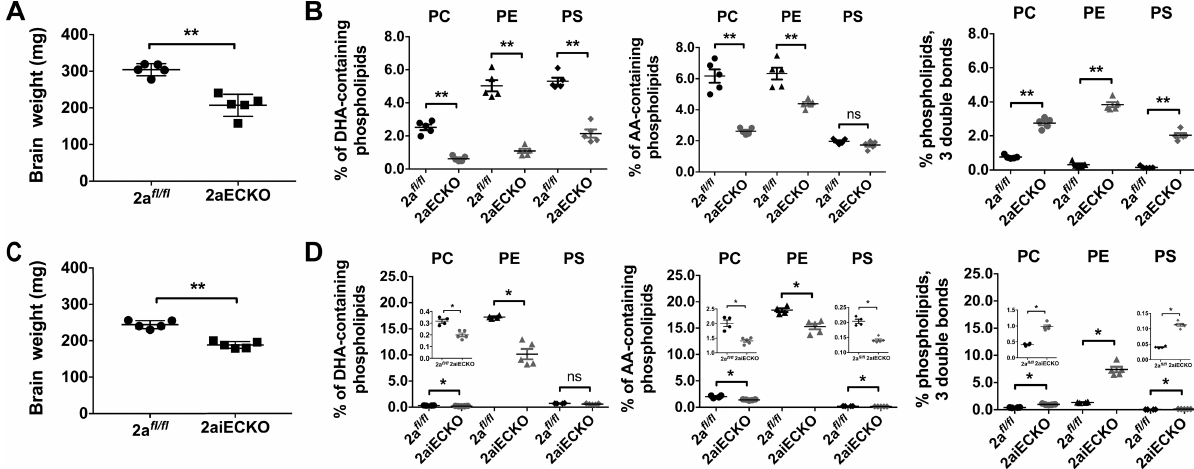
Fig 2. Mfsd2a expression at the BBB is indispensable for DHA accretion during postnatal brain growth. (A) Reduced brain weights of P8 2aECKO relative to 2a fl/fl mice. Data are represented as mean ± SE. 2a fl/fl , n = 5; 2aECKO, n = 5. (cid:3)(cid:3) p < 0.01. (B) Targeted lipidomic analysis of brains from P8 2a fl/fl and 2aECKO mice. Percentage PC, PE, and PS containing DHA, AA, and phospholipids with both fatty acids having a cumulative 3 double bonds are shown. Data are represented as mean ± SE. 2a fl/fl , n = 5; 2aECKO, n = 5; biological replicates. (cid:3)(cid:3) p < 0.01. (C) Reduced brain weights of P8 2aiECKO relative to 2a fl/fl mice. Data are represented as mean ± SE. 2a fl/fl , n = 5; 2aiECKO, n = 5. (cid:3)(cid:3) p < 0.01. (D) Targeted lipidomic analysis of brains from P8 2a fl/fl and 2aiECKO mice. Percentage PC, PE, and PS containing DHA, AA, and phospholipids with both fatty acids having a cumulative 3 double bonds are shown. Data are represented as mean ± SE. Inset contains enlarged scatterplots when differences between groups are obscured by the scale of the y- axis. 2a fl/fl , n = 4; 2aiECKO, n = 5; biological replicates. (cid:3) p < 0.05. Experimental data depicted in this figure can be found in S1 Data.